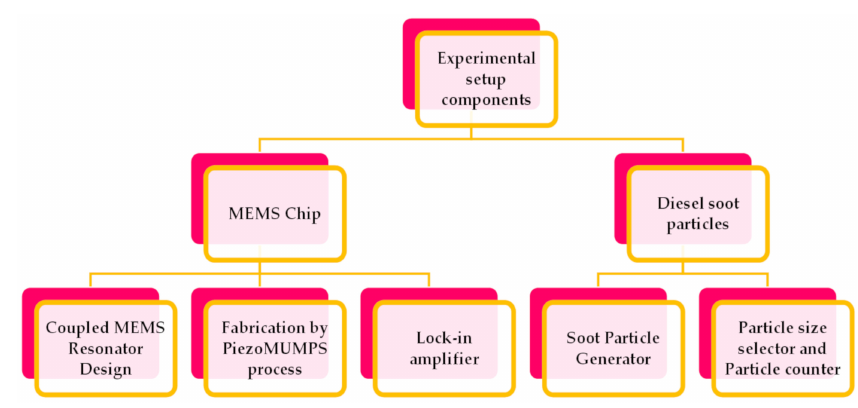
Figure 1. Di ff erent components of the experimental study.